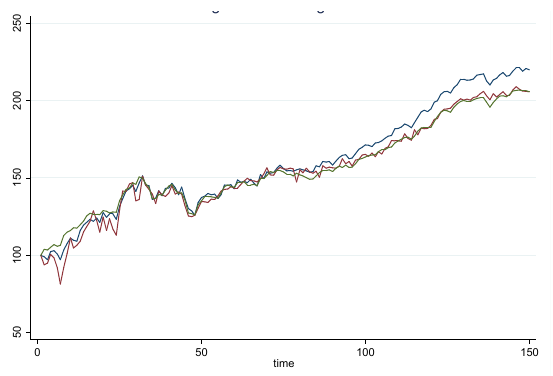
Figure 4. Size segments. Note: The apartment price index. The Stockholm housing market and segments of the market (the x -axis is the measuring price index and the y -axis is the measuring time). The red line is equal one-room apartments, the blue is equal 2–3 room apartments and the green line equal large apartments.